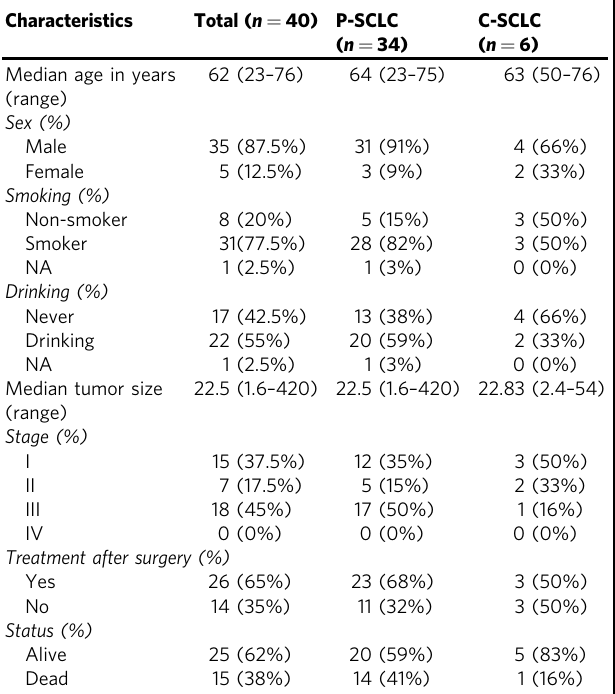
Table 1 Clinical characterization of our SCLC